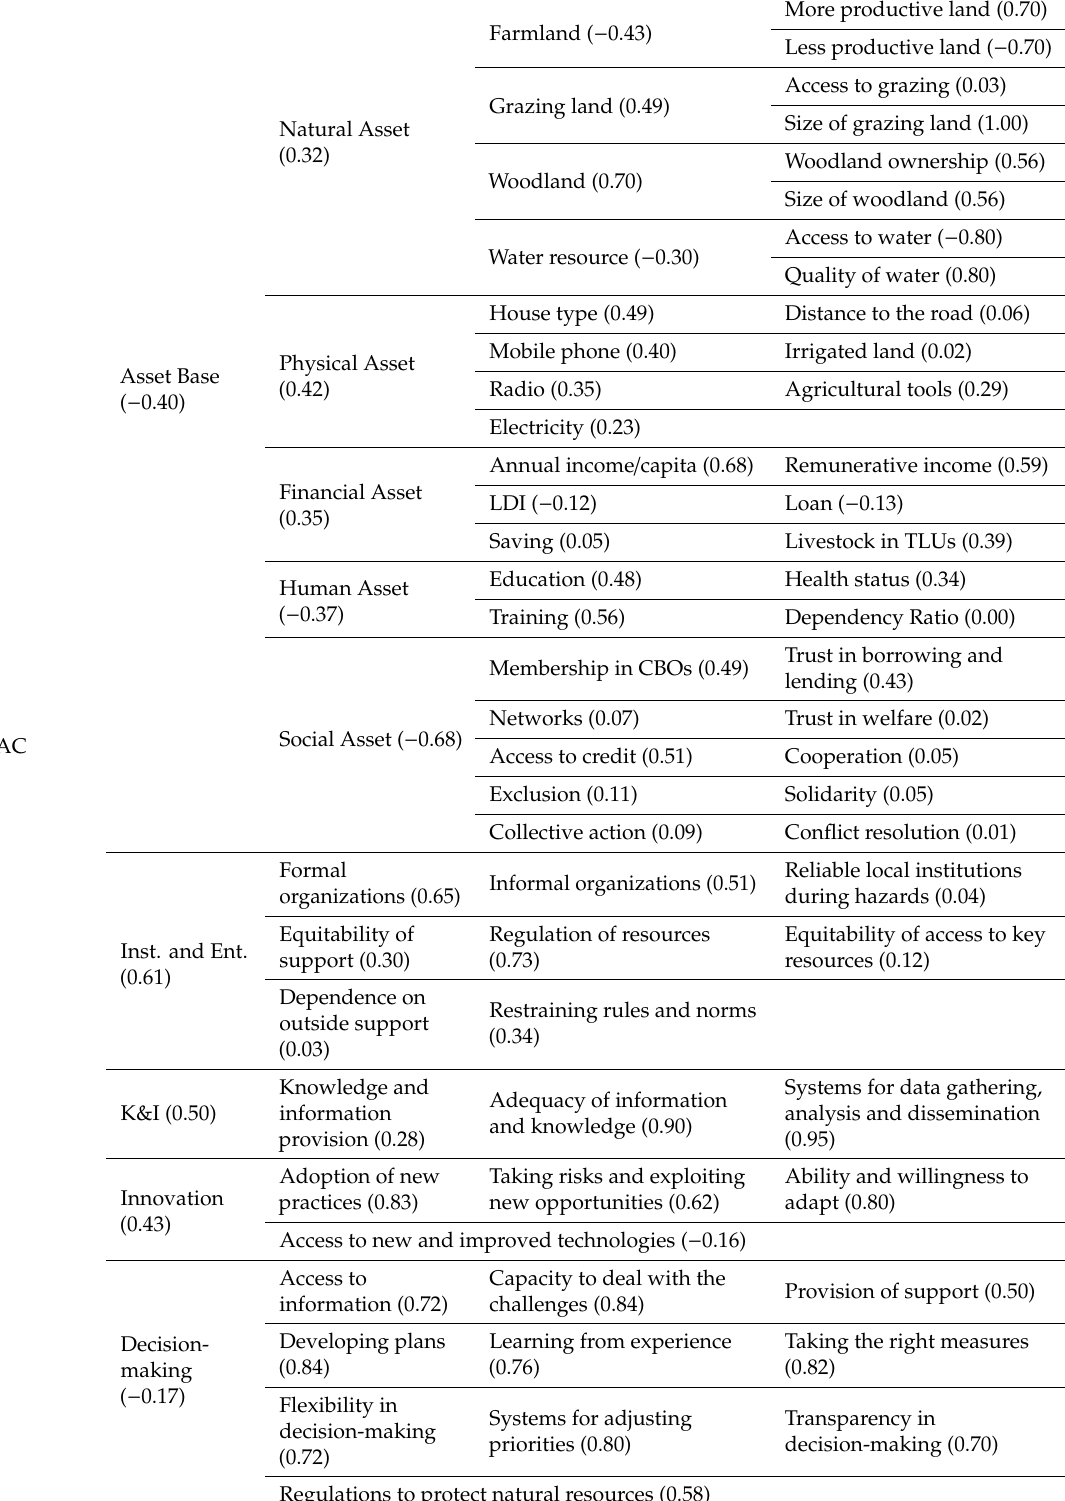
Overall structure of the aggregate adaptive capacity index, composite sub–indices, and component